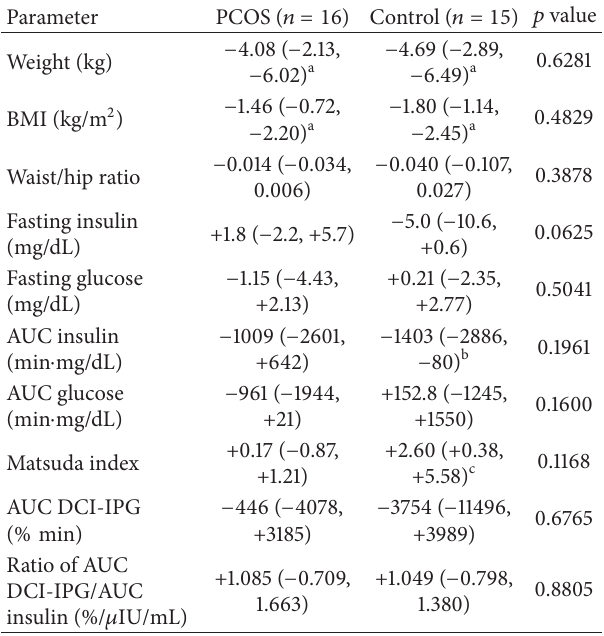
Table 2: Changes in metabolic parameters after 8 weeks of weight loss intervention in women with and without